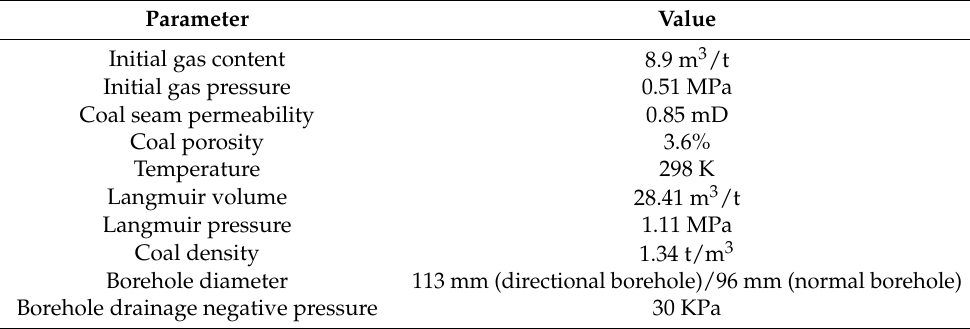
Table 4. Parameters of the simulation